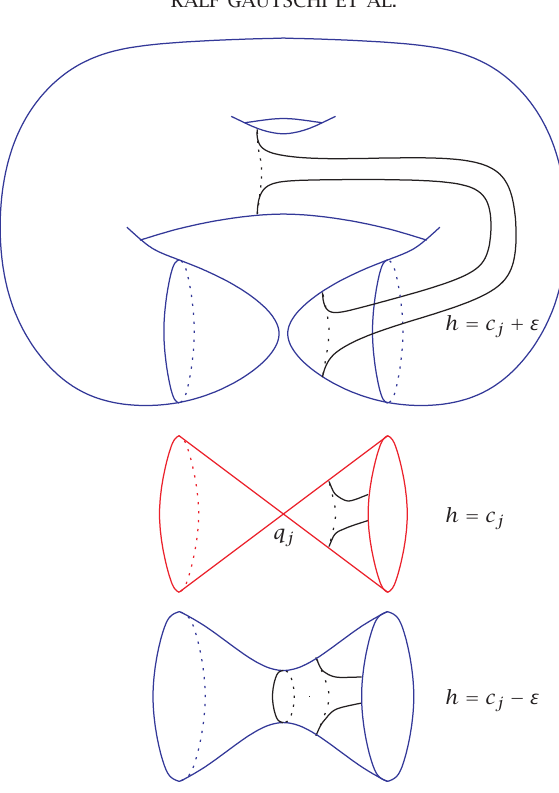
Figure 3.1 . The backward orbit of β